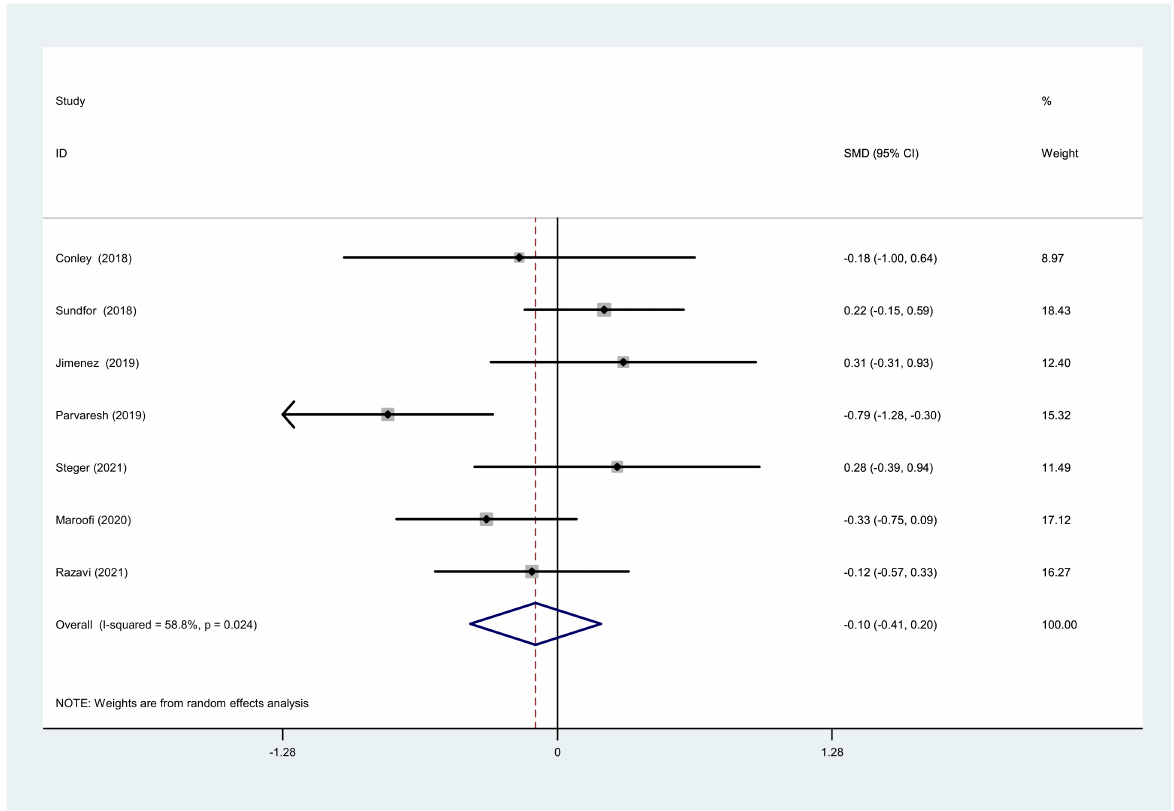
Figure 8. Forest plot of meta-analysis on comparing waist changes after IF and CCR